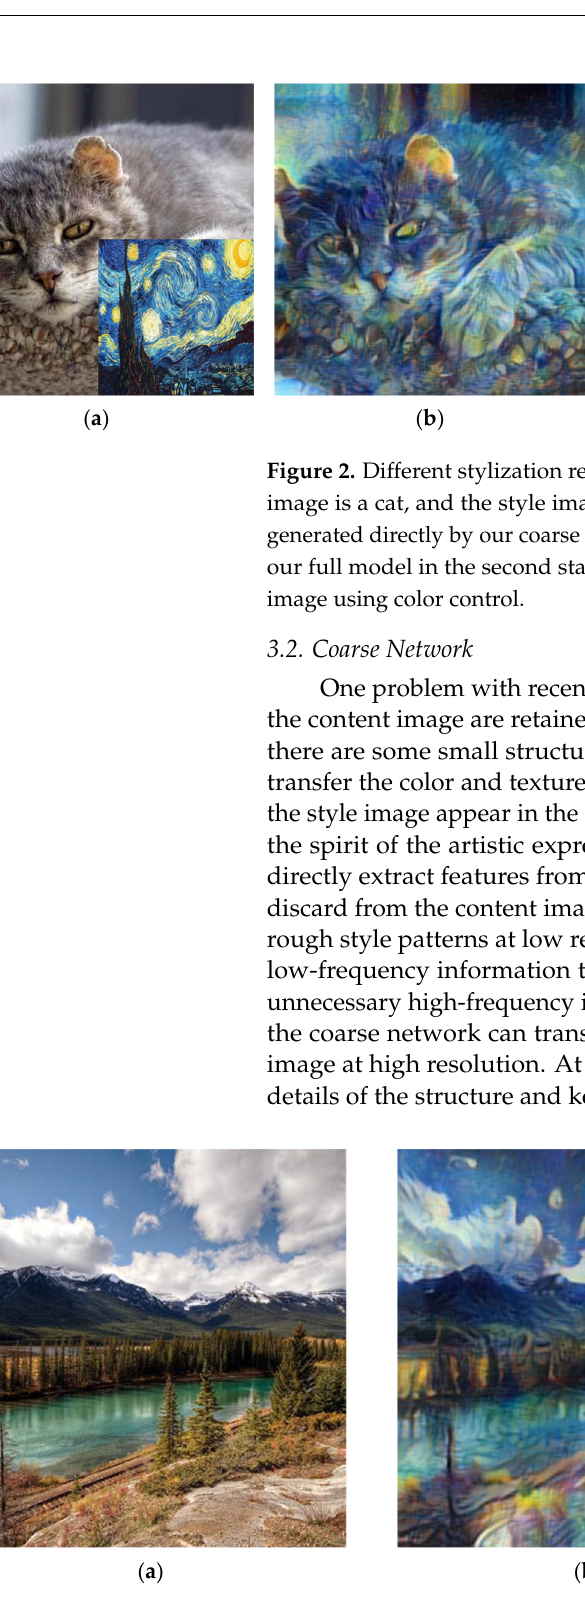
Figure 3. Comparison of two stylized images generated by the coarse network at different resolutions: ( a ) the original content image with resolution of 512 × 512; ( b ) the stylized image with resolution of 256 × 256; ( c ) the stylized image with resolution of 512 × 512.